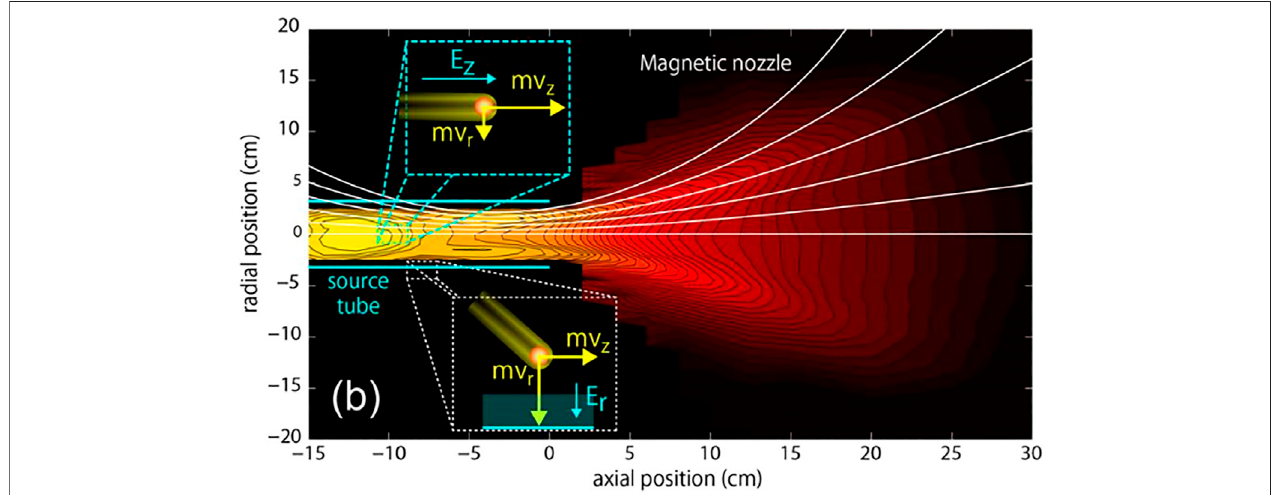
FIGURE 10 | The measured plasma pressure pro fi le and particle dynamics relating to the loss of axial momentum. Reproduced from [62]. Credit: Kazunori Takahashi.